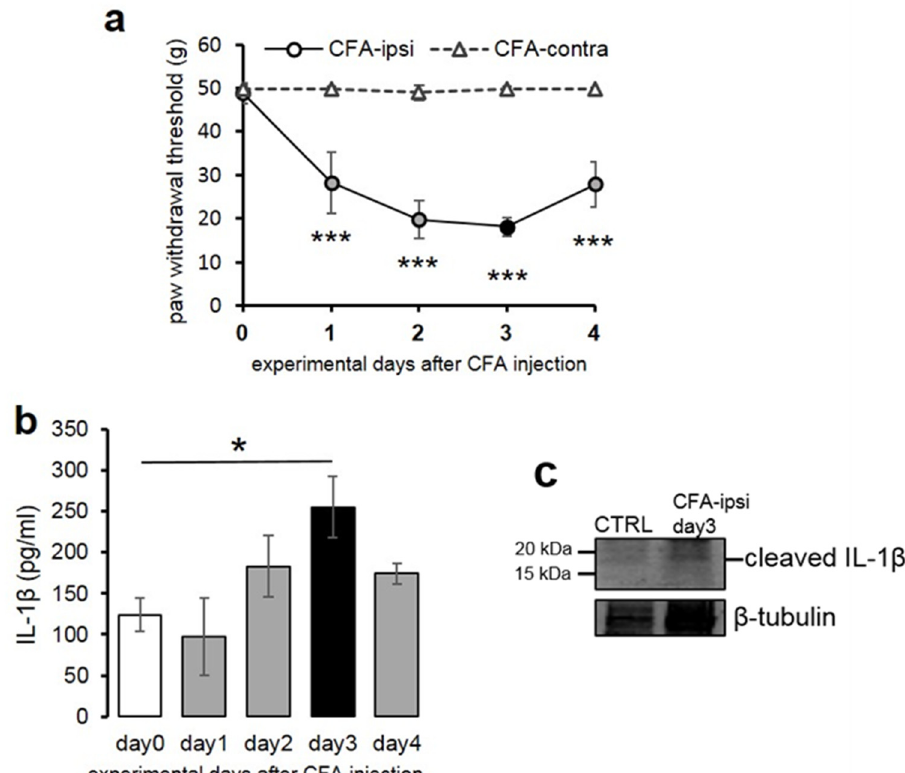
Figure 1. Decline of the mechanical withdrawal threshold is paralleled by the increase of spinal IL-1 β production during the course of CFA-induced peripheral inflammation. ( a ) The line chart shows the mean mechanical withdrawal threshold (MWT) values on both hind limbs of animals receiving CFA injection into the right (ipsilateral) hind paw. CFA injection resulted in a substantial drop in MWT values in the ipsilateral hind paw of the treated animals, which peaked at post-injection day 3 ( p = 0.000125). Data are presented as mean ± STD. ( b ) Bar chart shows quantitative ELISA measurement of IL-1 β levels in tissue extracts obtained from the L4–L5 lumbar segments of the spinal dorsal horn of the control (day 0) and CFA-injected animals at post-injection day 1–4. Data are shown as mean ± SEM. Note that the cytokine level reached significant elevation at post-injection day 3 ( p = 0.04). ( c ) Representative immuno-blot showing that the mature, cleaved IL-1 β reached the detection level in the tissue extract at post-injection day 3. * p < 0.5, *** p < 0.001.